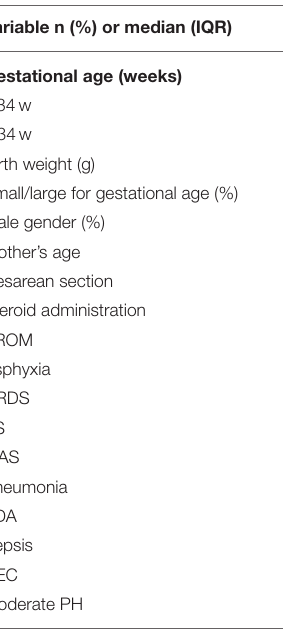
TABLE 1 | General information of the included